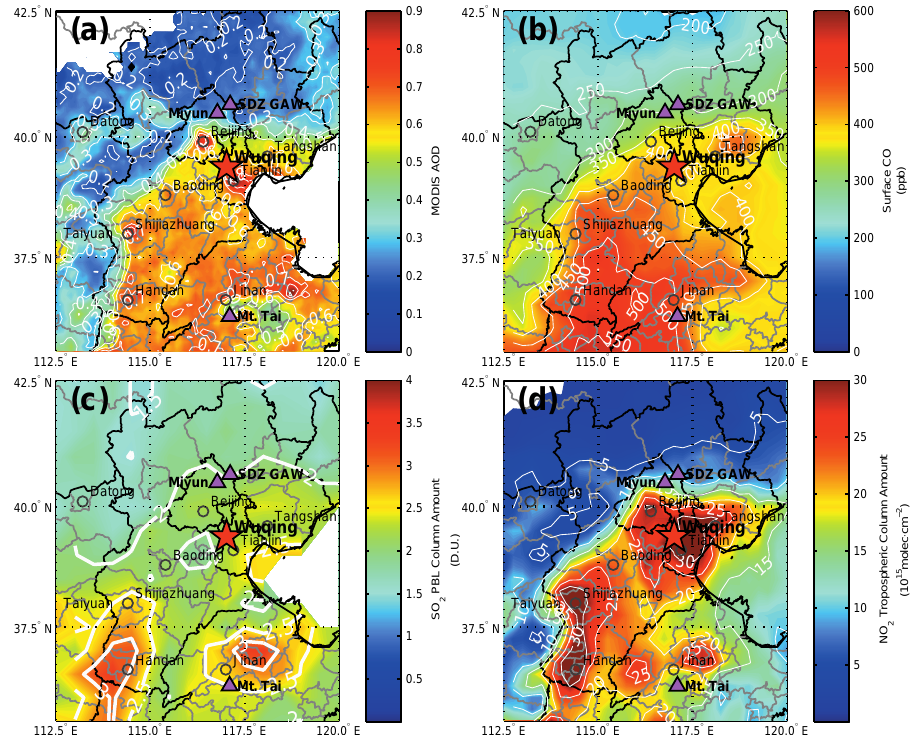
Fig. 4. 1 March 2009–1 March 2010 average distribution of (a) 550nm AOD (MODIS L2, resolution: 0.1 ◦ × 0.1 ◦ ); (b) CO Surface Mixing Ratio (MOPITT L2 Version 4, resolution: 0.25 ◦ × 0.25 ◦ ); (c) SO 2 Planetary Boundary Layer Column Amount (OMI L2,